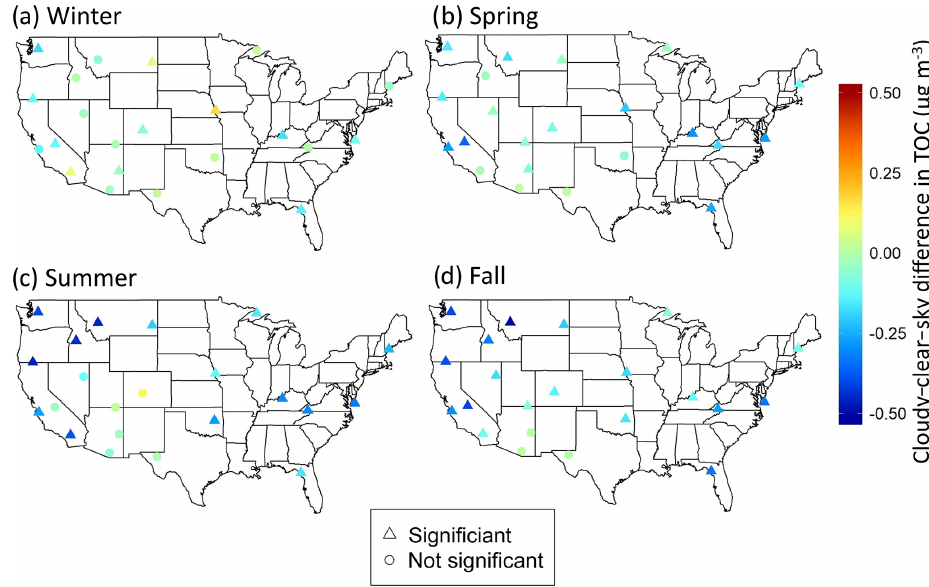
Figure A4. Maps of the difference in TOC mass concentration medians (cloudy–clear-sky) for all regions from 2010 to 2014 for (a) winter, (b) spring, (c) summer, and (d) fall. The color of the point corresponds to the magnitude of the difference. Triangles indicate that median differences are significant according to the Mann–Whitney U